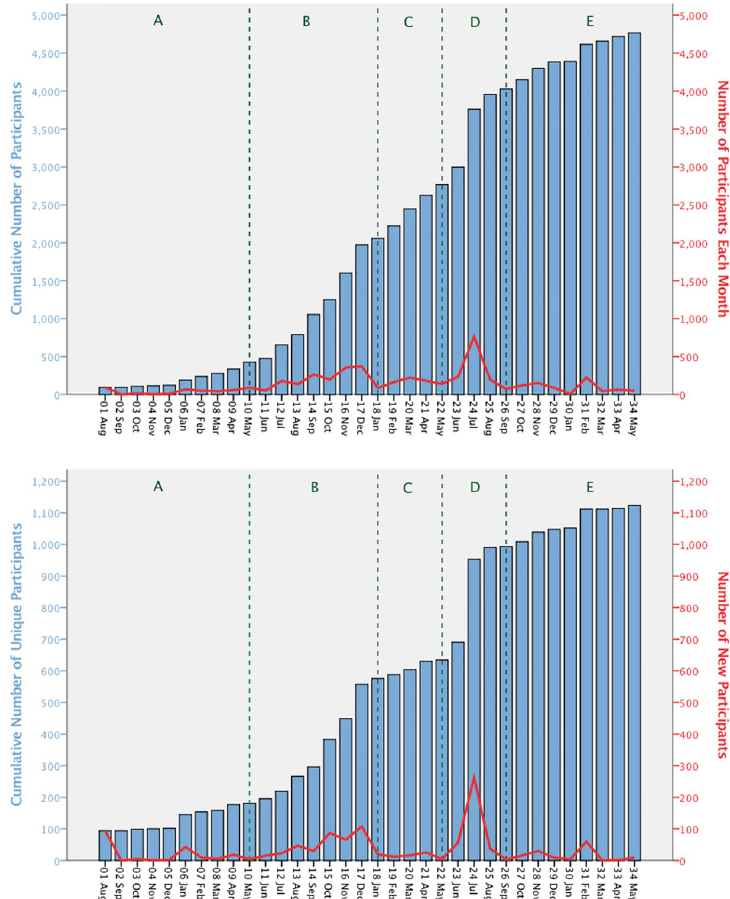
Fig 2. Number of nominal participants and unique participants in Uganda R4Ds. Nominal and unique participation in MSPs had similar patterns throughout the intervention period. Stable periods [A, C, E] were followed and preceded by periods of increase [B,